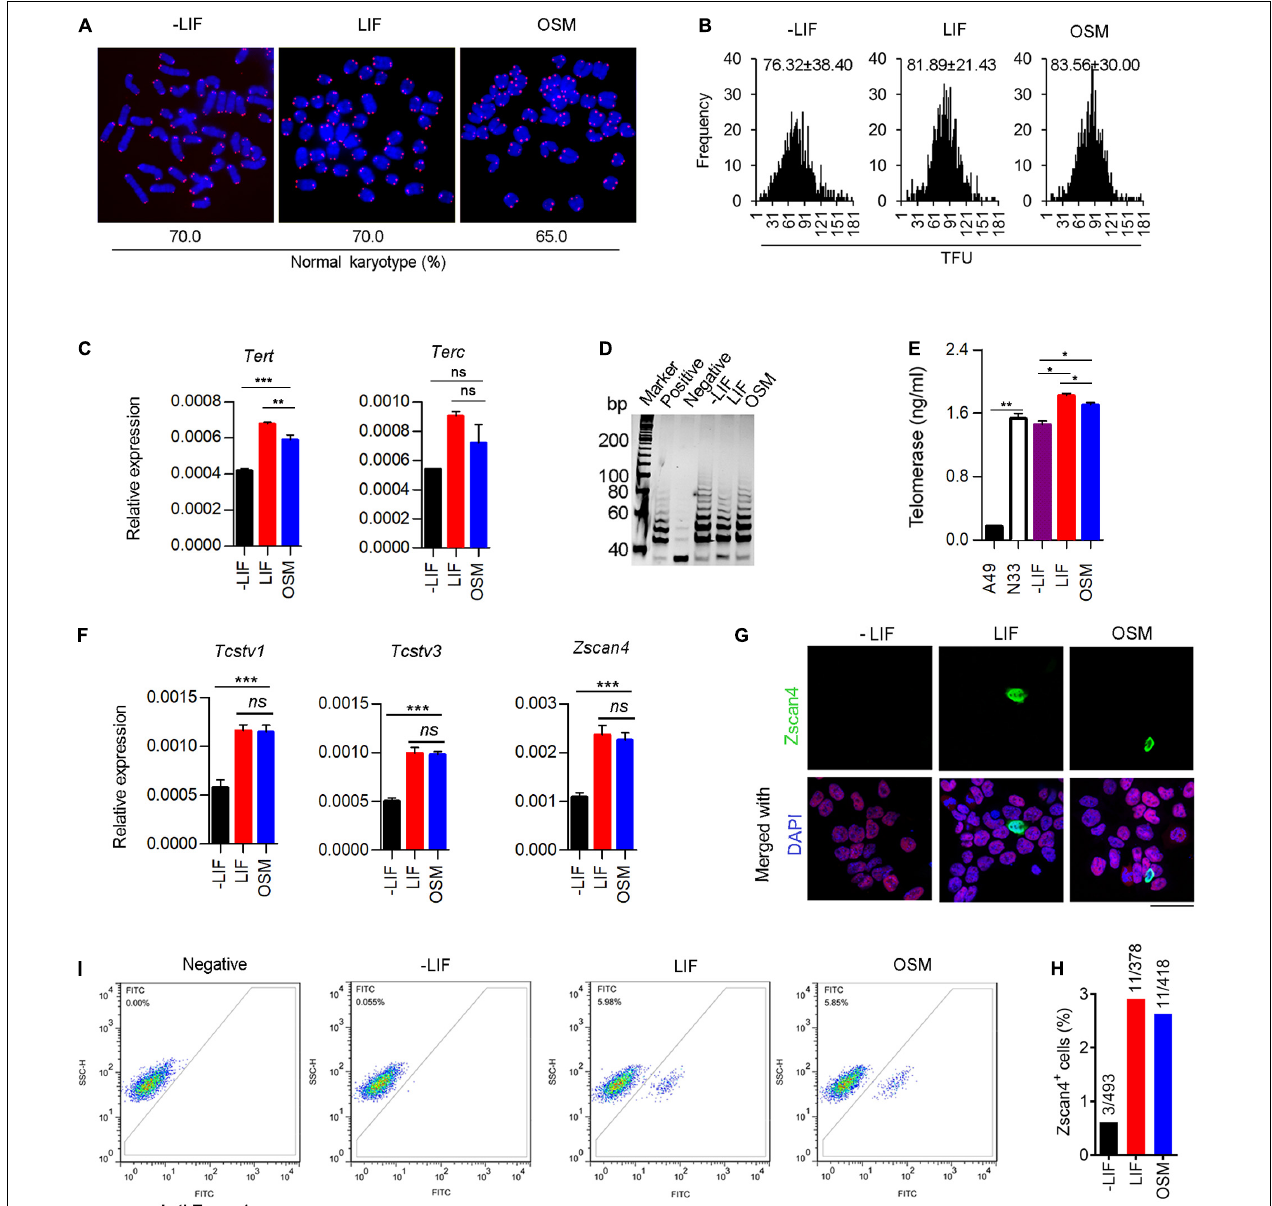
FIGURE 2 | OSM maintains telomere elongation, telomerase activity and heterogeneity in 2-cell gene expression. (A) Representative images displaying telomere Q-FISH of mESCs cultured in -LIF, LIF, and OSM medium. Blue, chromosomes stained with DAPI; Red dots, telomeres. Bottom panel, the ratio of normal karyotype in the three culture conditions. (B) Telomere Q-FISH assay showing telomere length distribution by telomere fluorescence unit (TFU). Data shown as Mean ± SD. (C) Expression of telomerase-related genes: Tert and Terc in mESCs cultured in -LIF, LIF and OSM medium. ** p < 0.01; *** p < 0.001; ns, no significant difference. (D) Telomerase activity measured by TRAP assay. Lysis buffer served as negative control. (E) Telomerase activity measured by ELISA assay. A49 mESCs ( Terc - / - G4 ESCs) and N33 mESCs (wild type ESCs) served as negative control and positive control, respectively. * p < 0.05; ** p < 0.01. (F) Relative expression of 2-cell genes including Tcstv1 , Tcstv3 , and Zscan4 in ESCs cultured in -LIF, LIF, and OSM medium. *** p < 0.001; ns, no significant difference. (G) Immunofluorescence staining of Zscan4 (green) and Oct4 (red) in ESCs cultured in -LIF, LIF, and OSM medium. Blue, DAPI. Scale bar, 20 µ m. (H) Percentage of Zscan4 + cells (number of mESCs counted in immunofluorescence staining assay). (I) Flow cytometry diagram indicating percentage of Zscan4 + cells in mESCs cultured in -LIF, LIF, and OSM medium. Samples lacking the antibody served as a negative